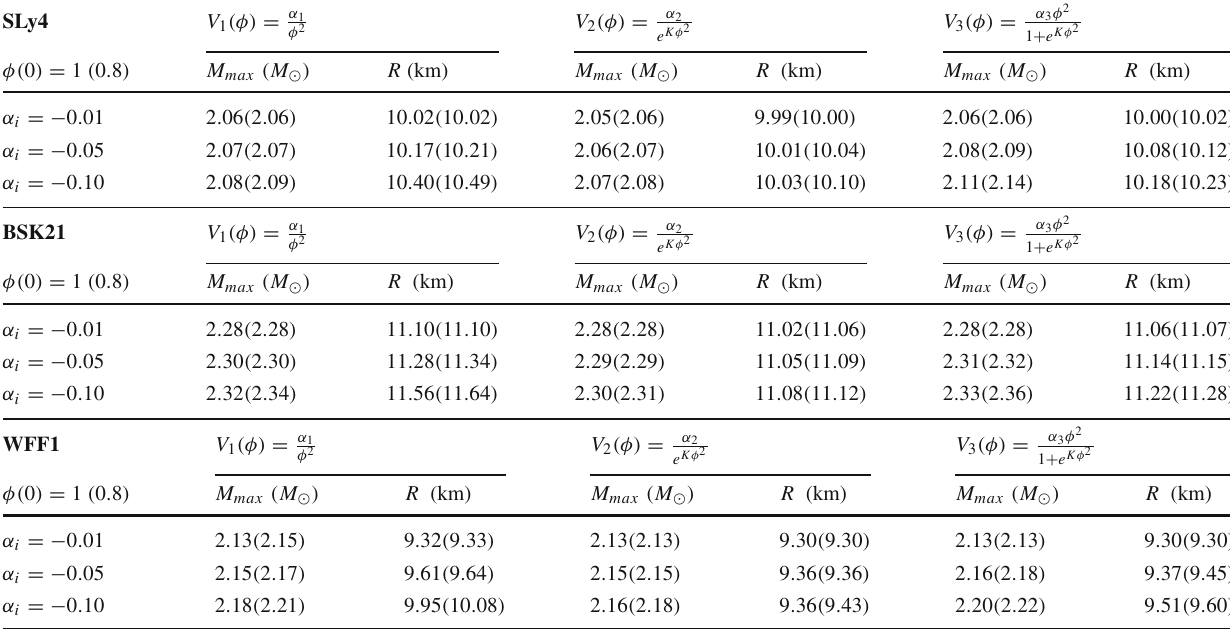
Table 2 M max and corresponding radius for non-relativistic EoSs with K = 0 . 5, φ( 0 ) = 1 (φ( 0 ) = 0 . 8 ) and various α i ( i = 1 .. 3